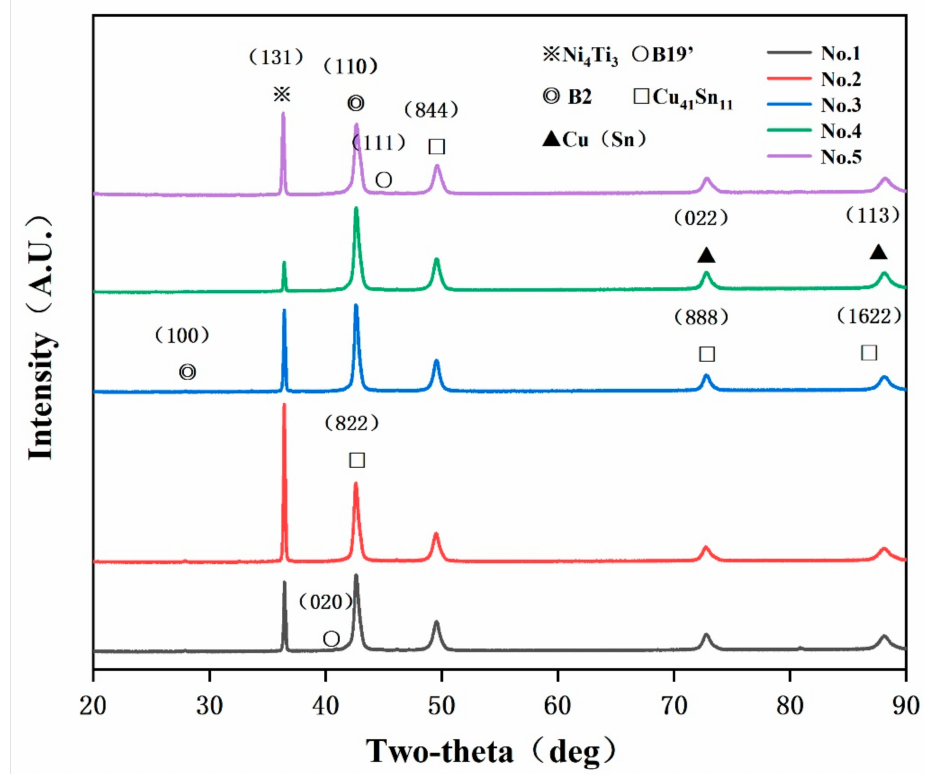
Figure 8. XRD pattern of the NiTi/CuSn10